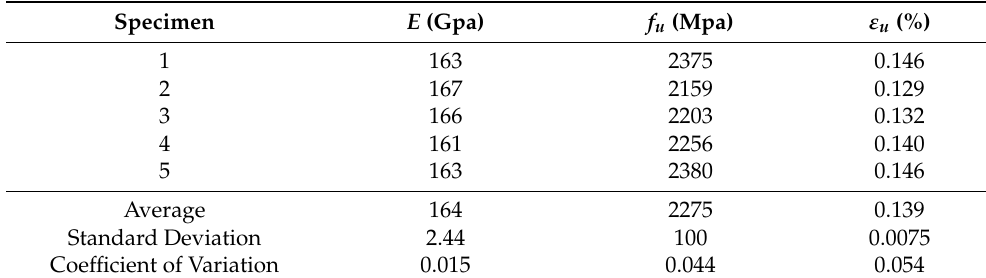
Table 7. CFRP tendon ( φ = 10 mm): (1) Young’s modulus ( E L ), (2) strength ( f u ), and (3) ultimate strain ( ε u